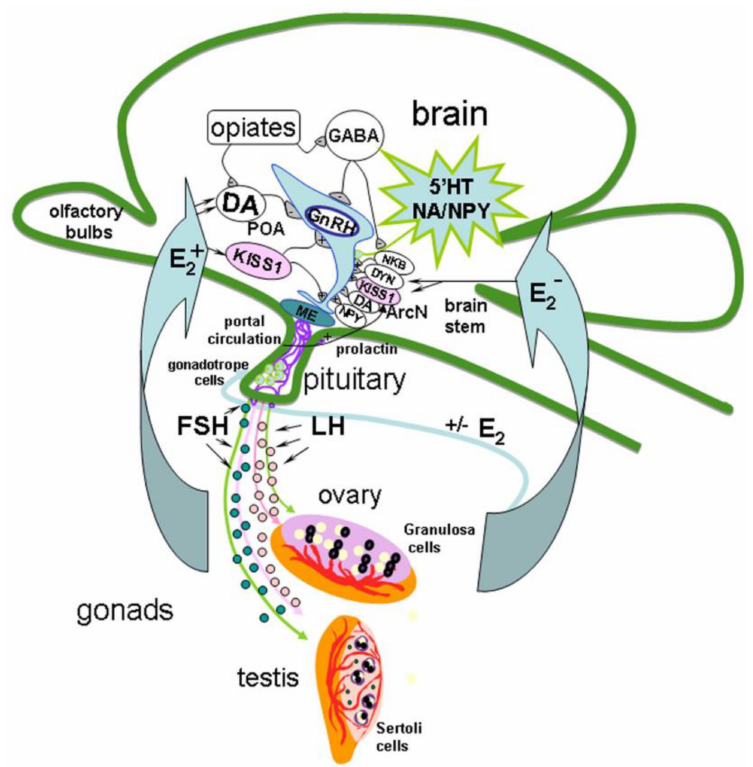
Figure 1. Model of the gonadotropin-releasing hormone (GnRH) neuron regulation in hypothalamic- pituitary-gonadal axis in adults. The mechanism of GnRH secretion regulation in the hypothalamus includes different signal molecules produced in different brain regions such as preoptic area (POA), locus coeruleus, raphe nucleus and brain stem, in particularly, serotonin (5 (cid:48) HT), dopamine (DA), noradrenaline (NA), gamma-aminobutyric acid (GABA), kisspeptin (KISS1), neuropeptide Y (NPY), opiates, neurokinin B (NKB) and dynorphin (DYN), which colocalize with KISS1 in the arcuate nucleus (ArcN), are also involved in the generation of GnRH impulses. NKB initiates the onset of GnRH impulse secretion in median eminence (ME), and DYN initiates its termination. In turn, axons of GnRH neurons release GnRH into the portal system in necessary concentration to trigger luteinizing hormone (LH) and follicle-stimulating hormone (FSH) secretion, which stimulate the secretion of sex steroids. Sex steroids, in turn, regulate the GnRH and LH synthesis in the brain and